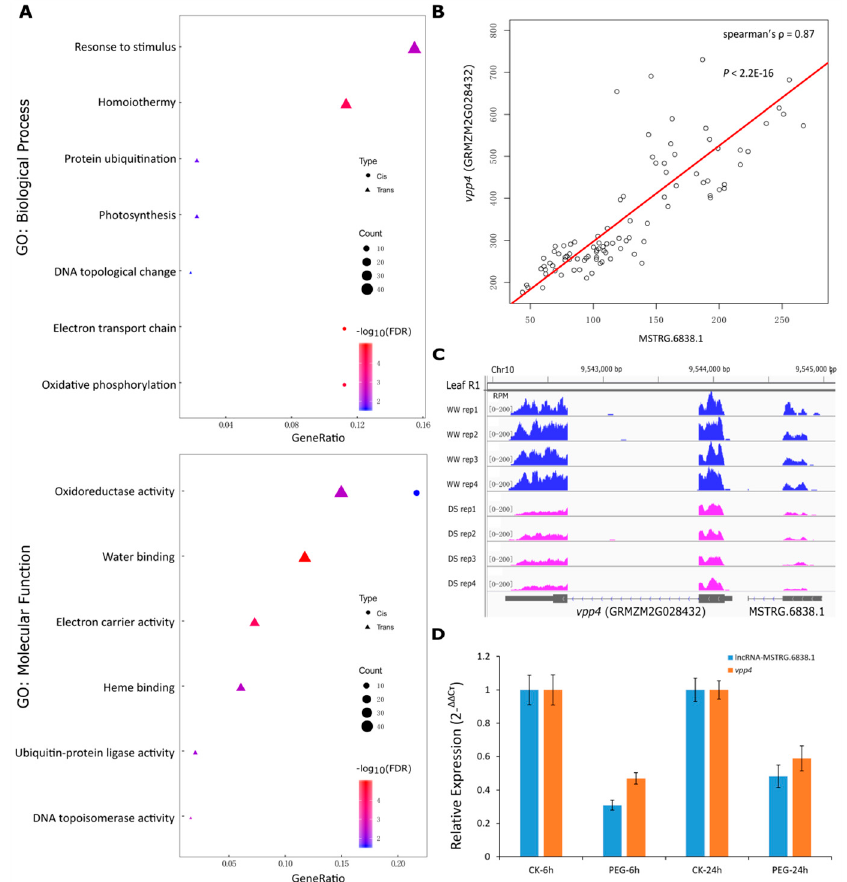
Figure 4. Prediction of targets and potential functional roles of drought responsive lncRNAs. ( A ) GO enrichments for the putative targets of the DE lncRNAs. The targets of the cis -acting and trans -acting lncRNAs were separately analyzed, and were represented using circle and triangle, respectively. The number of genes in each term was reflected by the size of the shapes, and the terms were ranked by the ratio of the lncRNA targets falling in each term to the total number of the lncRNA targets ( x -axis). The significance of the enrichments was represented by the colors, where red represents a more significant enrichment than blue. ( B ) The expression correlation of the gene vpp4 and its adjacent lncRNA MSTRG.6838.1. The x -axis marks the expression level (FPKM) of the lncRNA MSTRG.6838.1, while the y-axis marks the expression level (FPKM) of vpp4 . ( C ) The reads coverage of the genomic regions of vpp4 and MSTRG.6838.1 at leaf R1 stage. The first four lanes highlight the four replicates under well-watered condition, while the other four highlight the four replicates under drought stress condition. The abundance of the reads coverage was measured by RPM (Reads Per Million). ( D ) qRT-PCR validation of lncRNA MSTRG.6838.1 and its putative target vpp4 (GRMZM2G028432) in leaf of 2-week-old seedlings of the maize inbred B73. Seedlings were untreated or treated with 25% PEG6000-induced osmotic stress for 6h and 24h. For each gene, the transcript level in the untreated plants (CK) was defined as 1. Data represent means ± standard deviation (SD) of three replicates.